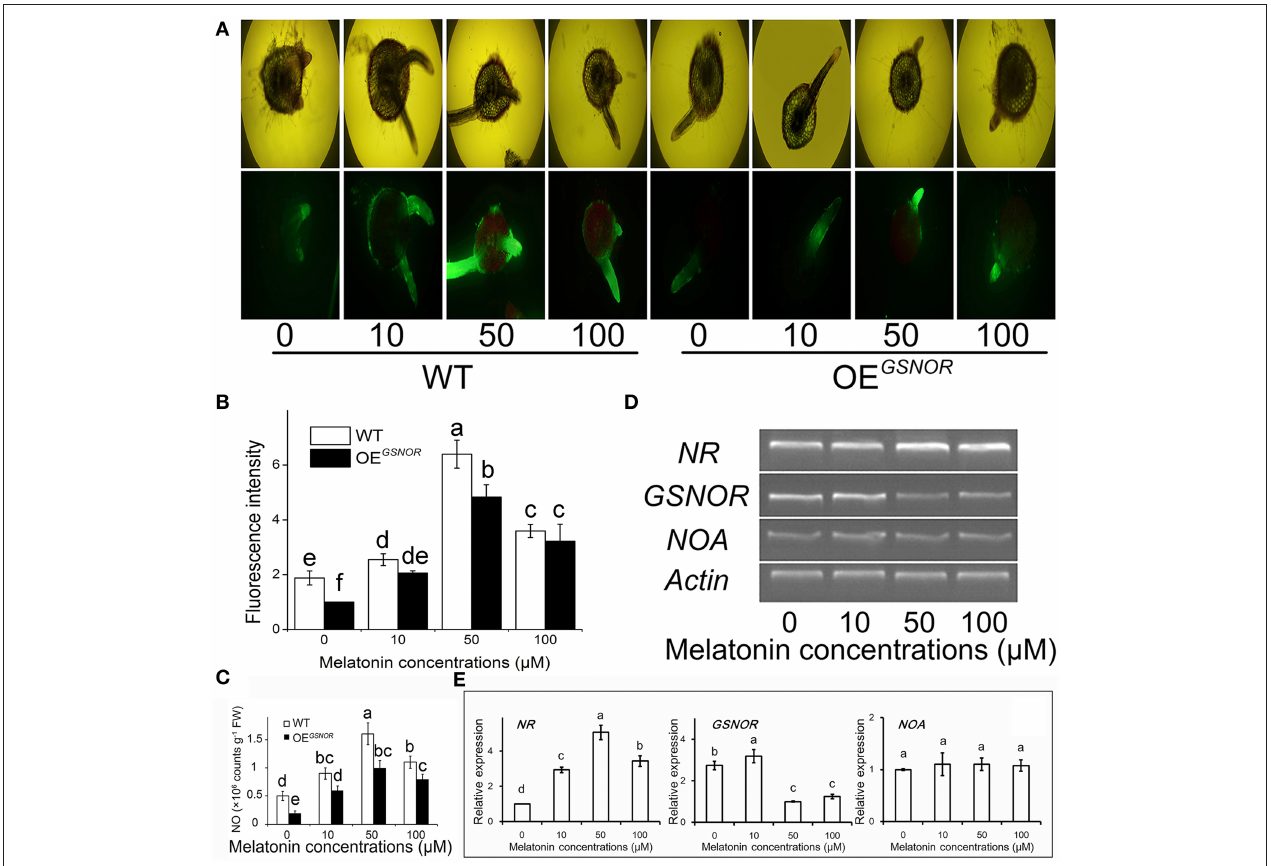
FIGURE 2 | Effects of exogenous MT on endogenous NO metabolism. (A) Detection of contents of MT-induced NO by fluorescence staining. 4,5-Diamino-fluorescein diacetate fluorescence detected in a cross section from 3mm distance to the tip of the hypocotyls, where new meristematic tissue and adventitious root formed. Photographs were taken after 3 days of treatment. WT indicates WT tomato and OE GSNOR indicates tomato overexpressing GSNOR. (B) NO content in different treatments. (C) Relative expression of NO metabolism related genes. Values are expressed as means of three replicates ± SD, and different letters indicate significant difference ( p < 0.05). (D) Fluorescence intensity of NO expressed as arbitrary units (A.U.) using ImageJ software. The same letter above a column indicates no difference at p < 0.05. (E) Expressions of NR , GSNOR and NOA measured by RT-QPCR. Values are expressed as means of three replicates ± SD, and different letters indicate significant difference ( p <